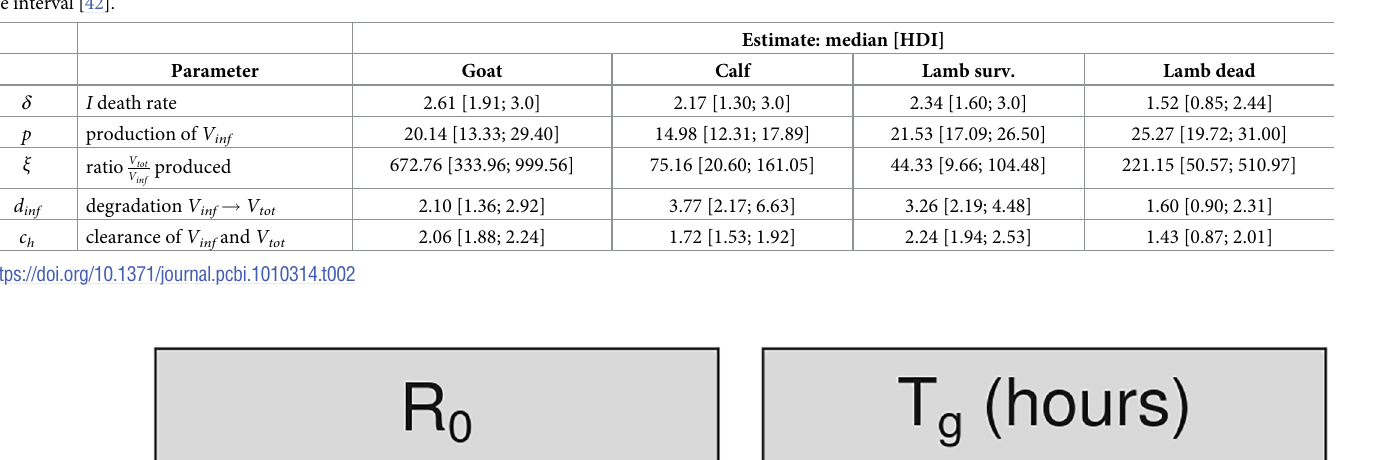
with Eq (4). Note that generation times are g